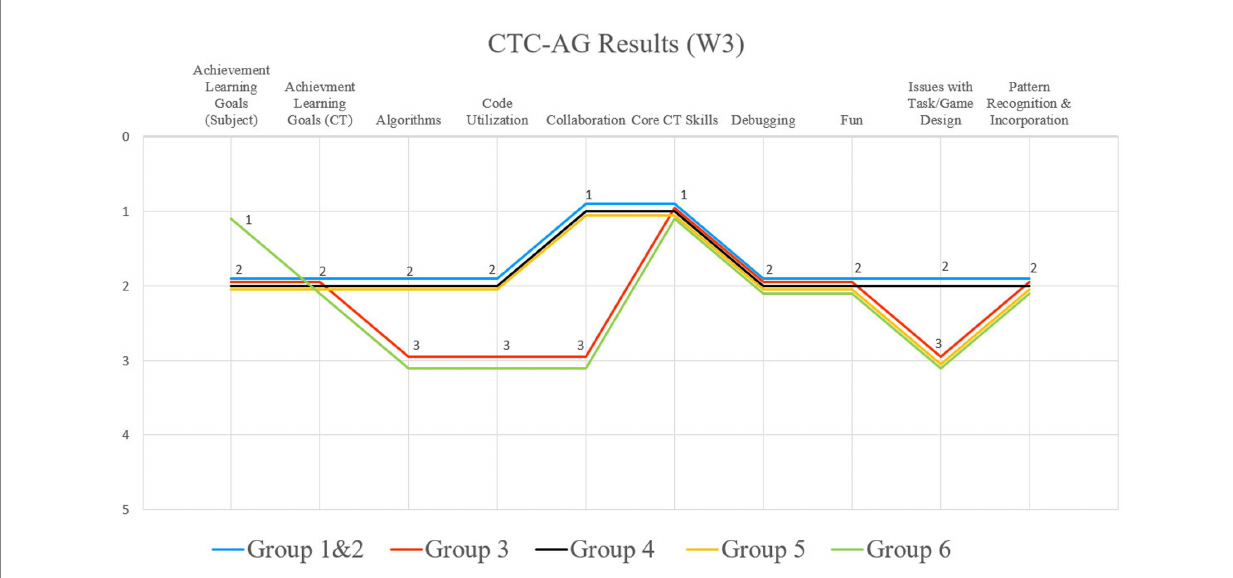
FIGURE 12 Results of the comparison of all six participating groups from workshop 3. The Y-axis shows the grades 1–5, according to the researcher, and the X-axis is showing excerpts of the CTC-AG items.